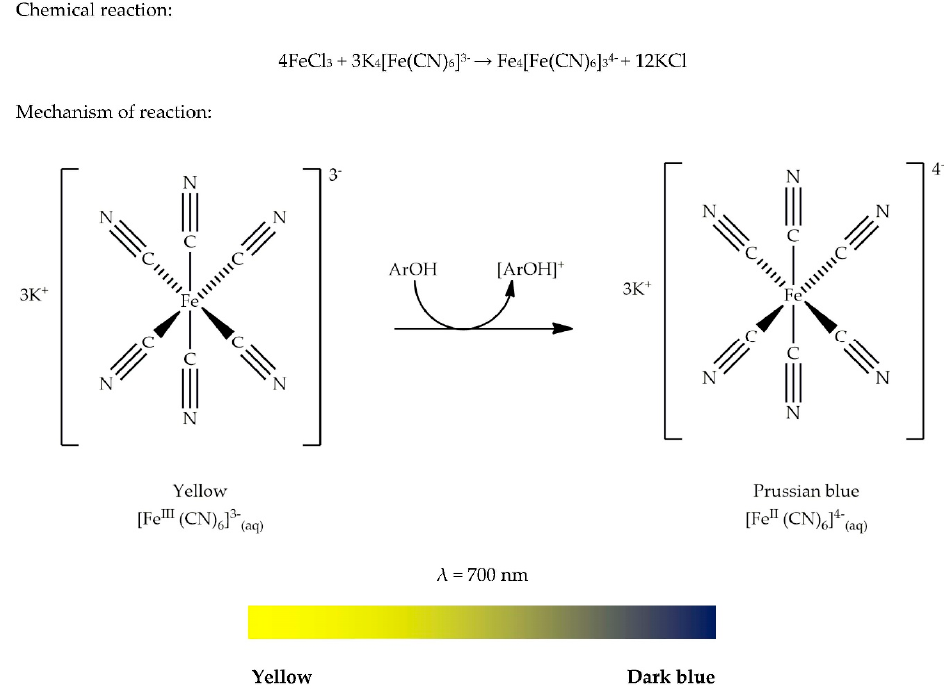
Figure 14. Potassium ferricyanide reaction mechanism.